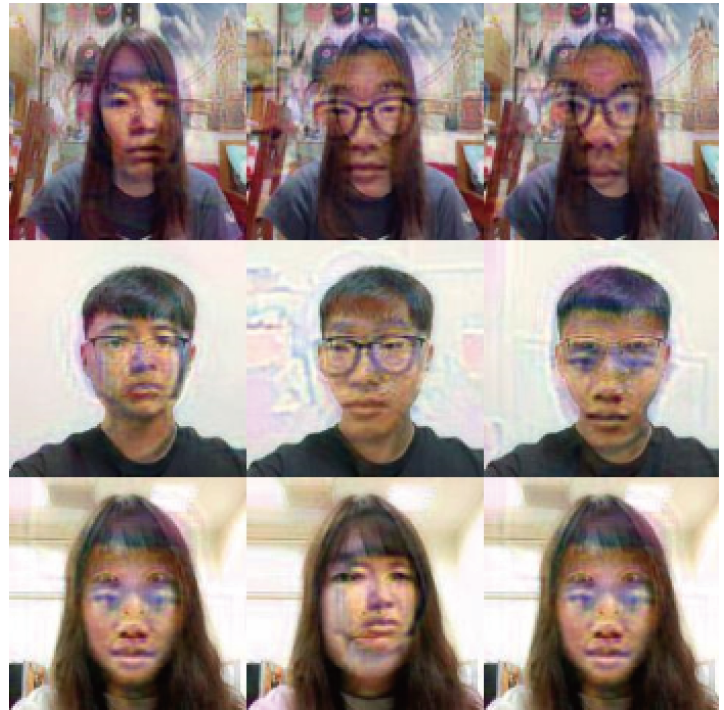
Figure 5. Generated adversarial faces.